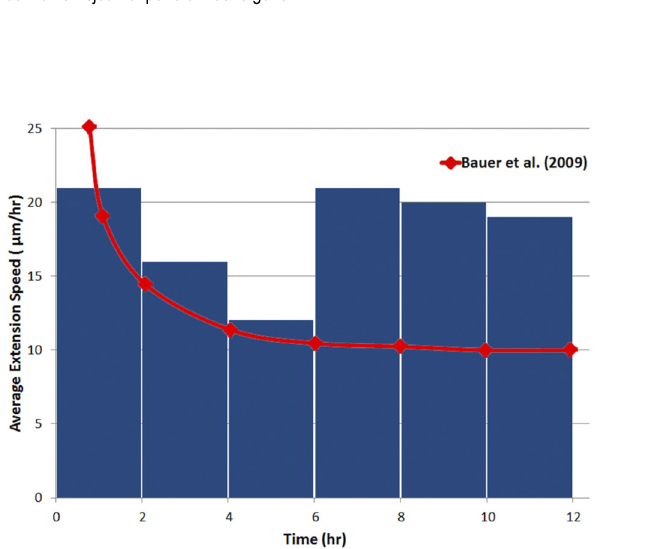
Fig 18. Comparison of number of ECs between two sprouts extend in parallel and two sprouts in a closed loop. The number of ECs is averaged over 10 independent simulations.